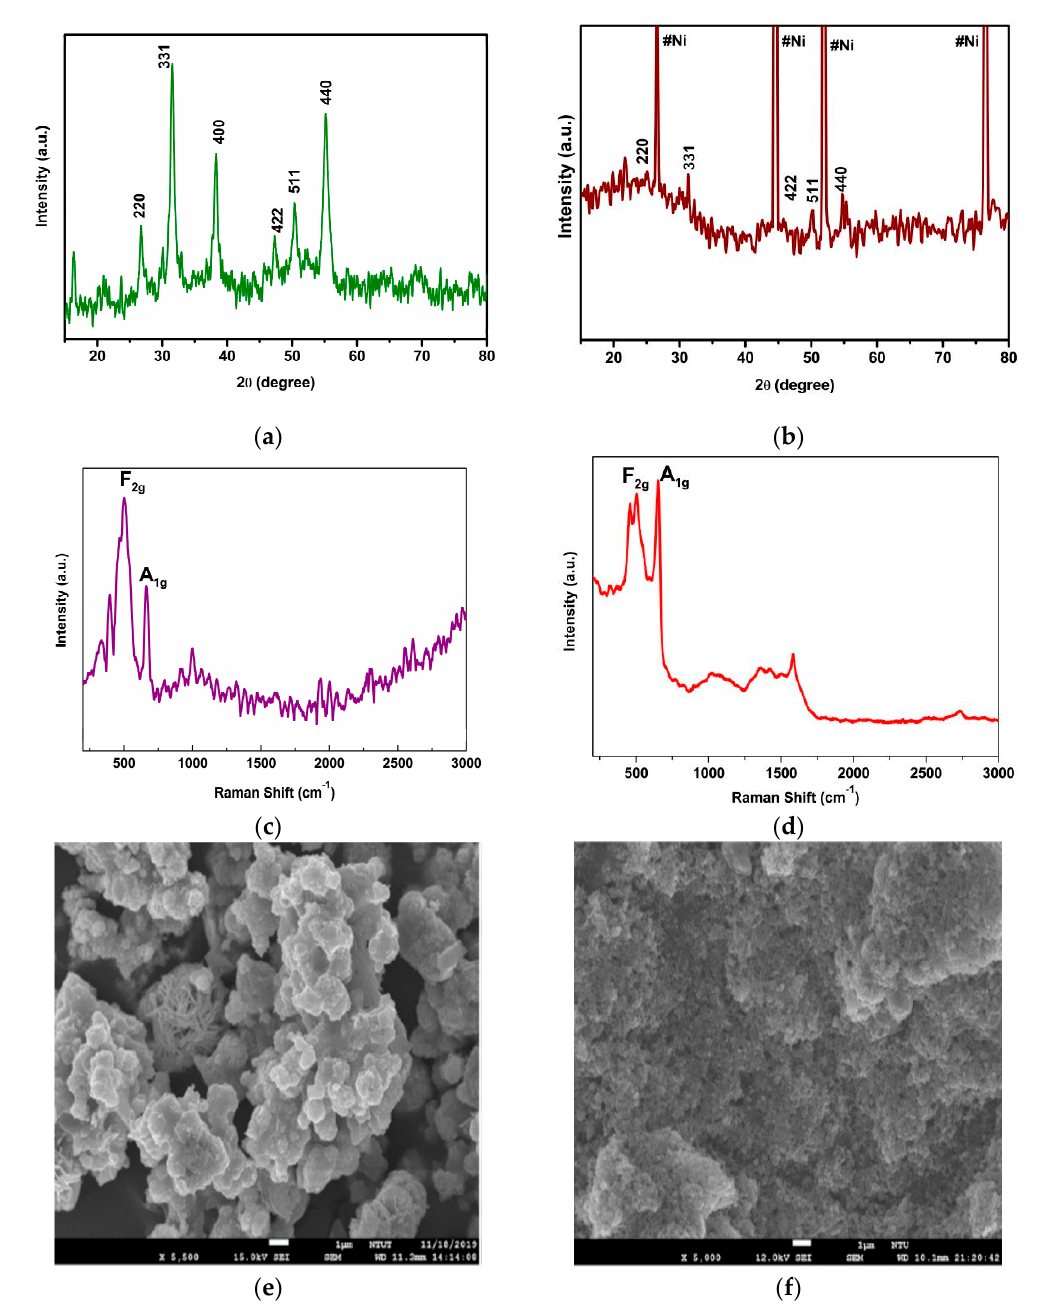
Figure 3. Structural and morphological analysis of NiCo 2 S 4 : ( a ) X-ray diffraction analysis of NiCo 2 S 4 synthesized by the hydrothermal method, ( b ) X-ray diffraction analysis of NiCo 2 S 4 synthesized by the CBD method; ( c , d ) Raman spectroscopic analysis of NiCo 2 S 4 synthesized by the hydrothermal and CBD methods, respectively; ( e , f ) FESEM images of NiCo 2 S 4 synthesized by the hydrothermal and CBD methods, respectively.